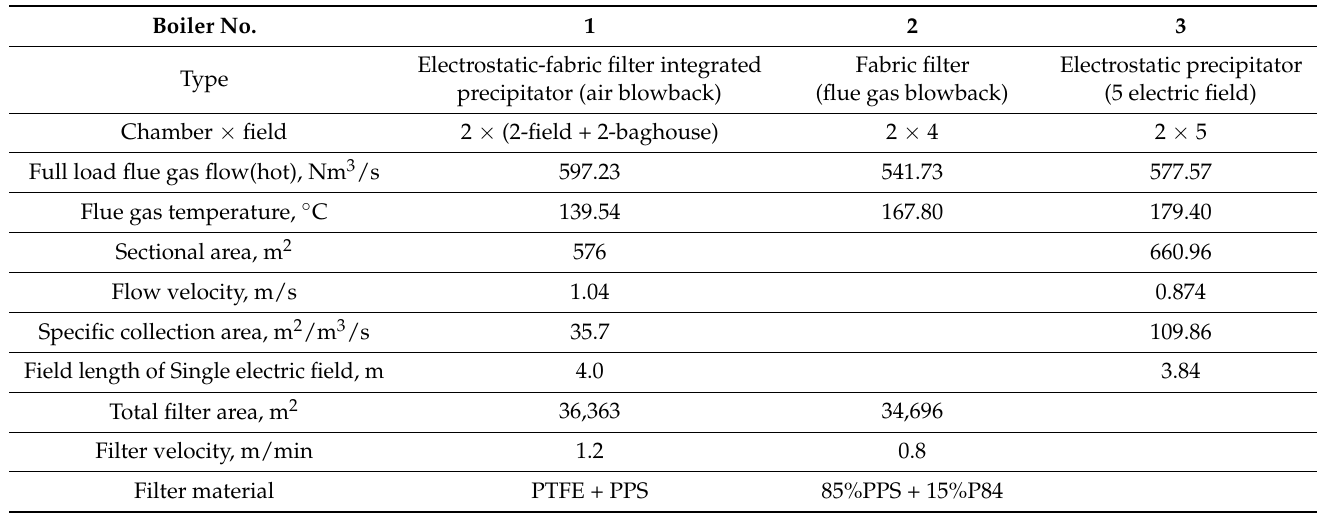
Table 6. Key parameters of the dust collectors of three boilers.